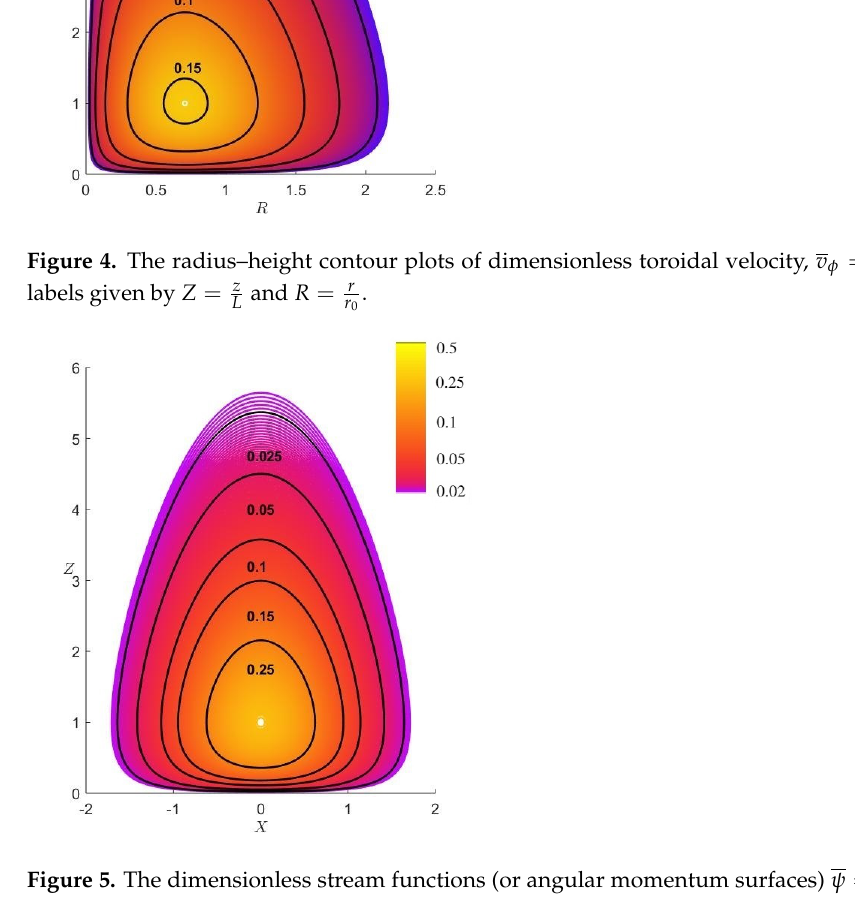
and X = x , where x ∈ [ − r , r ] r 0 L